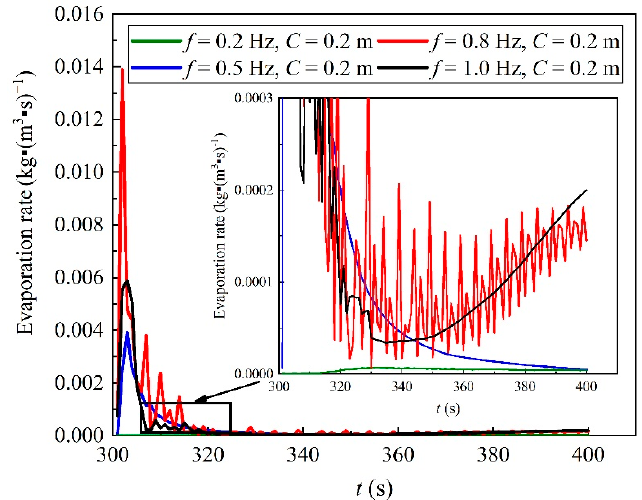
Figure 11. Variation of evaporation rate with different sloshing frequencies.